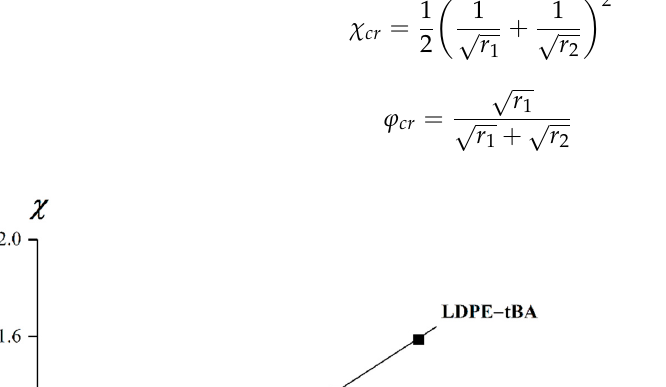
Figure 5. Binodal curves for tBA systems with LDPE, EVA ‐ 7, and EVA ‐ 20. It was found that the solubility of the components improved with increasing temperature. The compositions are characterized by a phase diagram of amorphous phase separation with the UCST [58,59]. For systems with LDPE and EVA ‐ 7 the critical temperature is located in the region of high ‐ volatility tBA and was not experimentally determined (Figure 5).